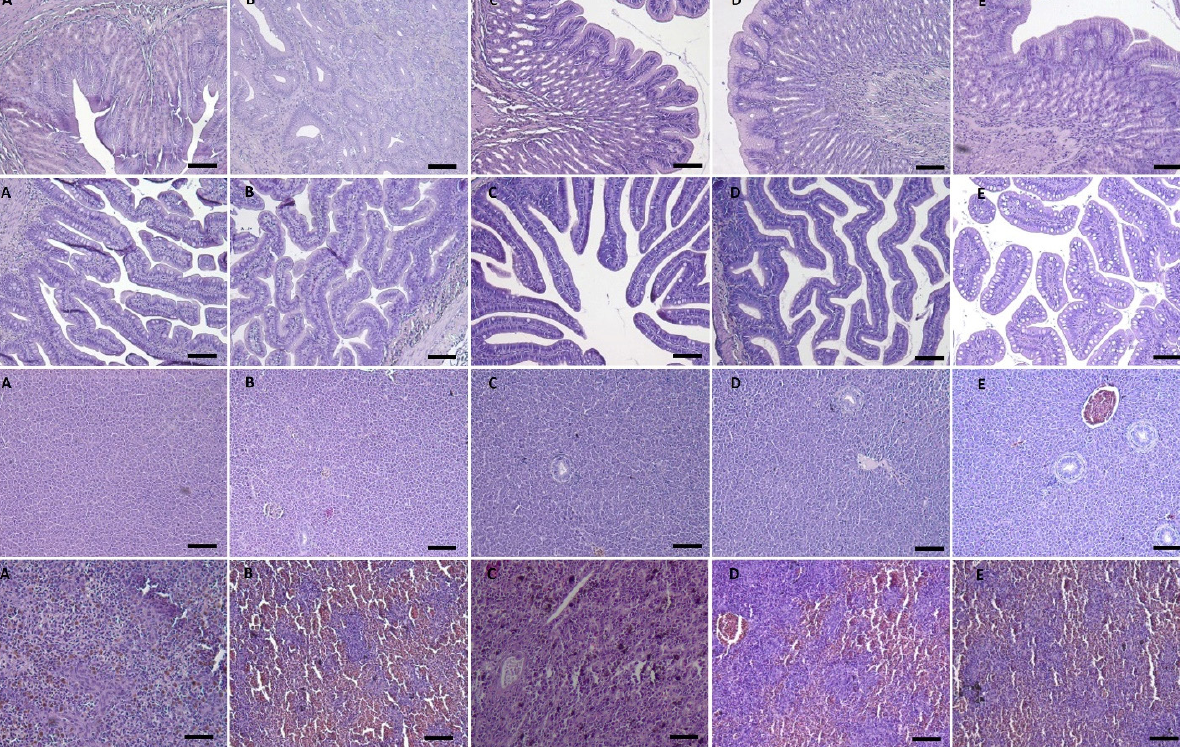
Figure 13. Stomach ( first line ), intestine ( second line ), liver ( third line ) and spleen ( fourth line ) of salmon at different sampling times. ( A ) Control. ( B ) 1 week after exposure. ( C ) 2 weeks after exposure. ( D ) 3 weeks after exposure. ( E ) 4 weeks after exposure. Scale bar: 100 µm.